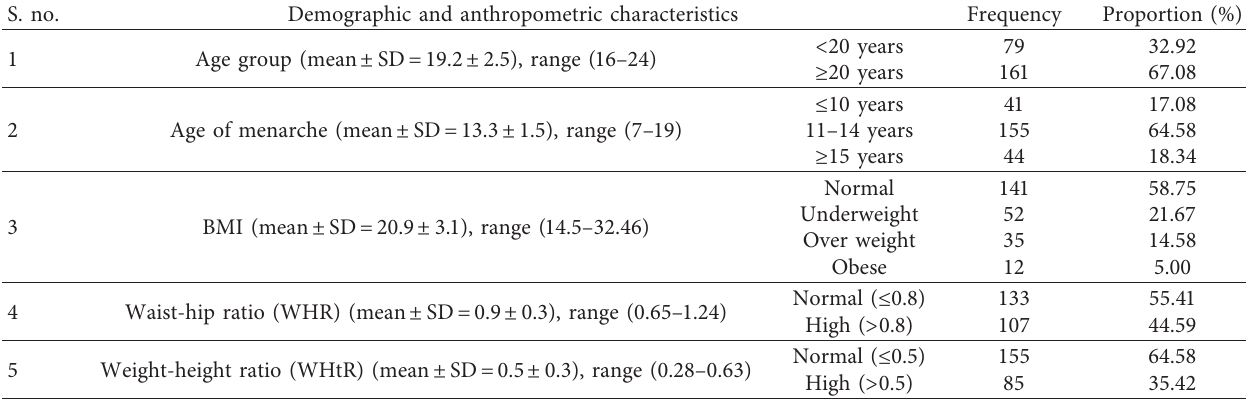
Table 1: Demographic and anthropometric characteristics of study participants ( N � 240). S. no.